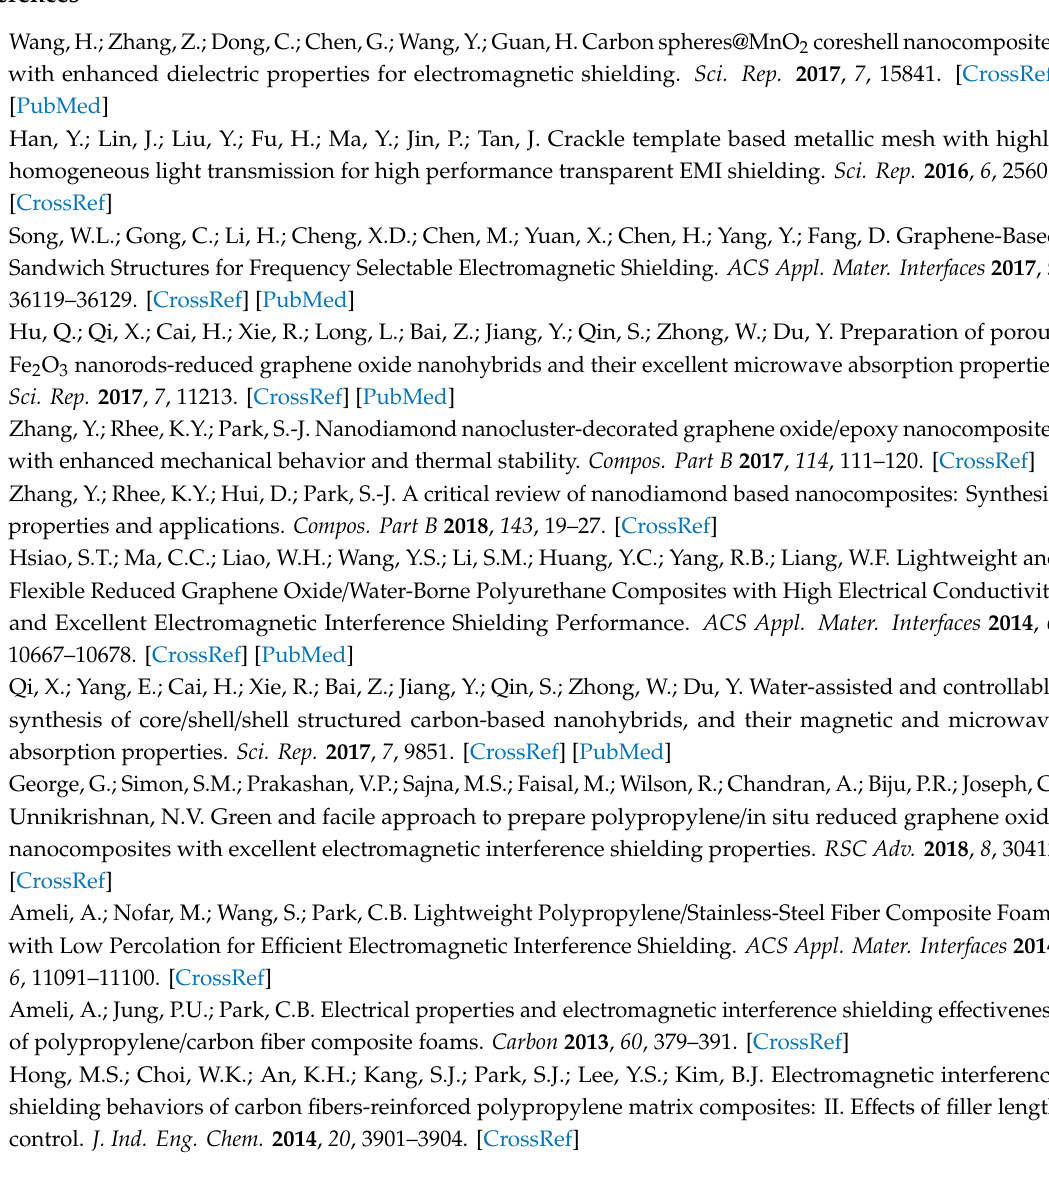
Figure S1: SEM images of cross section of (a) NiFe 2 O 4 -Polypropylene (b) NiFe 2 O 4 -1wt%RGO-Polypropylene, (c) NiFe 2 O 4 -3wt%RGO-Polypropylene, and (d) NiFe 2 O 4